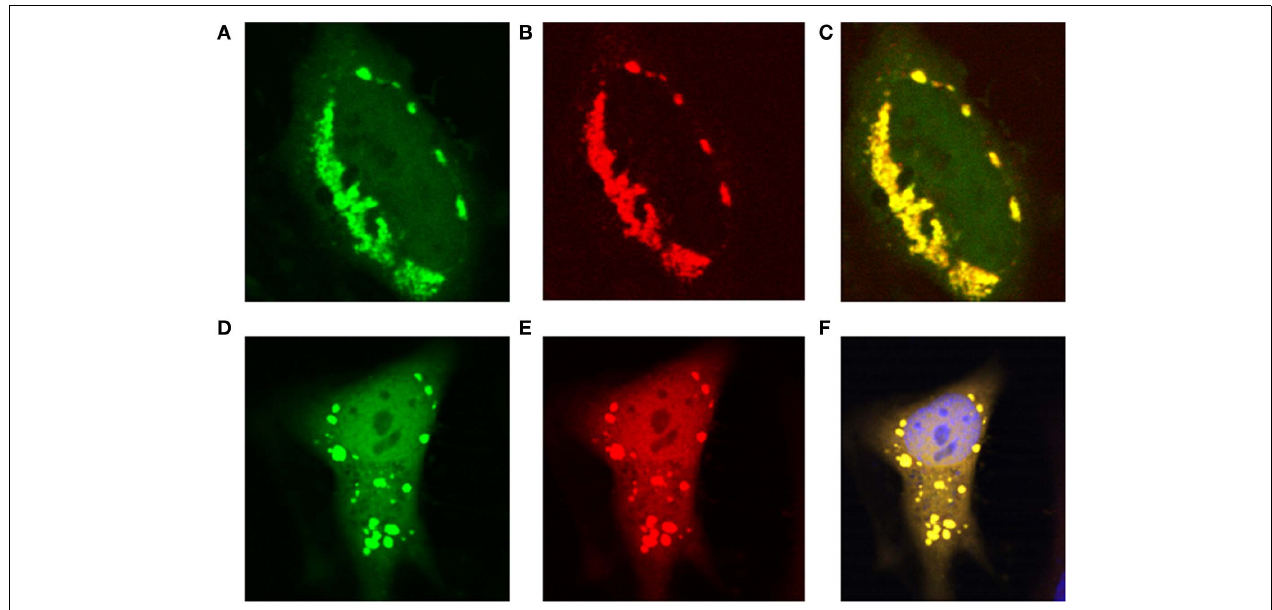
FIGURE 8 | MTHFS-GFP co-localizes with hTrifGART-OFP and hFGAMS-OFP under purine-depleted conditions. Fluorescent fusion proteins were expressed in HeLa cells maintained in purine-deficient RPMI as described in Section “Materials and methods.” (A) hMTHFS-GFP fusion protein, (B) hFGAMS-OFP fusion protein, (C) merge of (A) and (B) . (D) hMTHFS-GFP fusion protein, (E) hTrifGART-OFP fusion protein, (F) merge of (D) and (E) ; nuclear stain (DRAQ5) shown in blue.